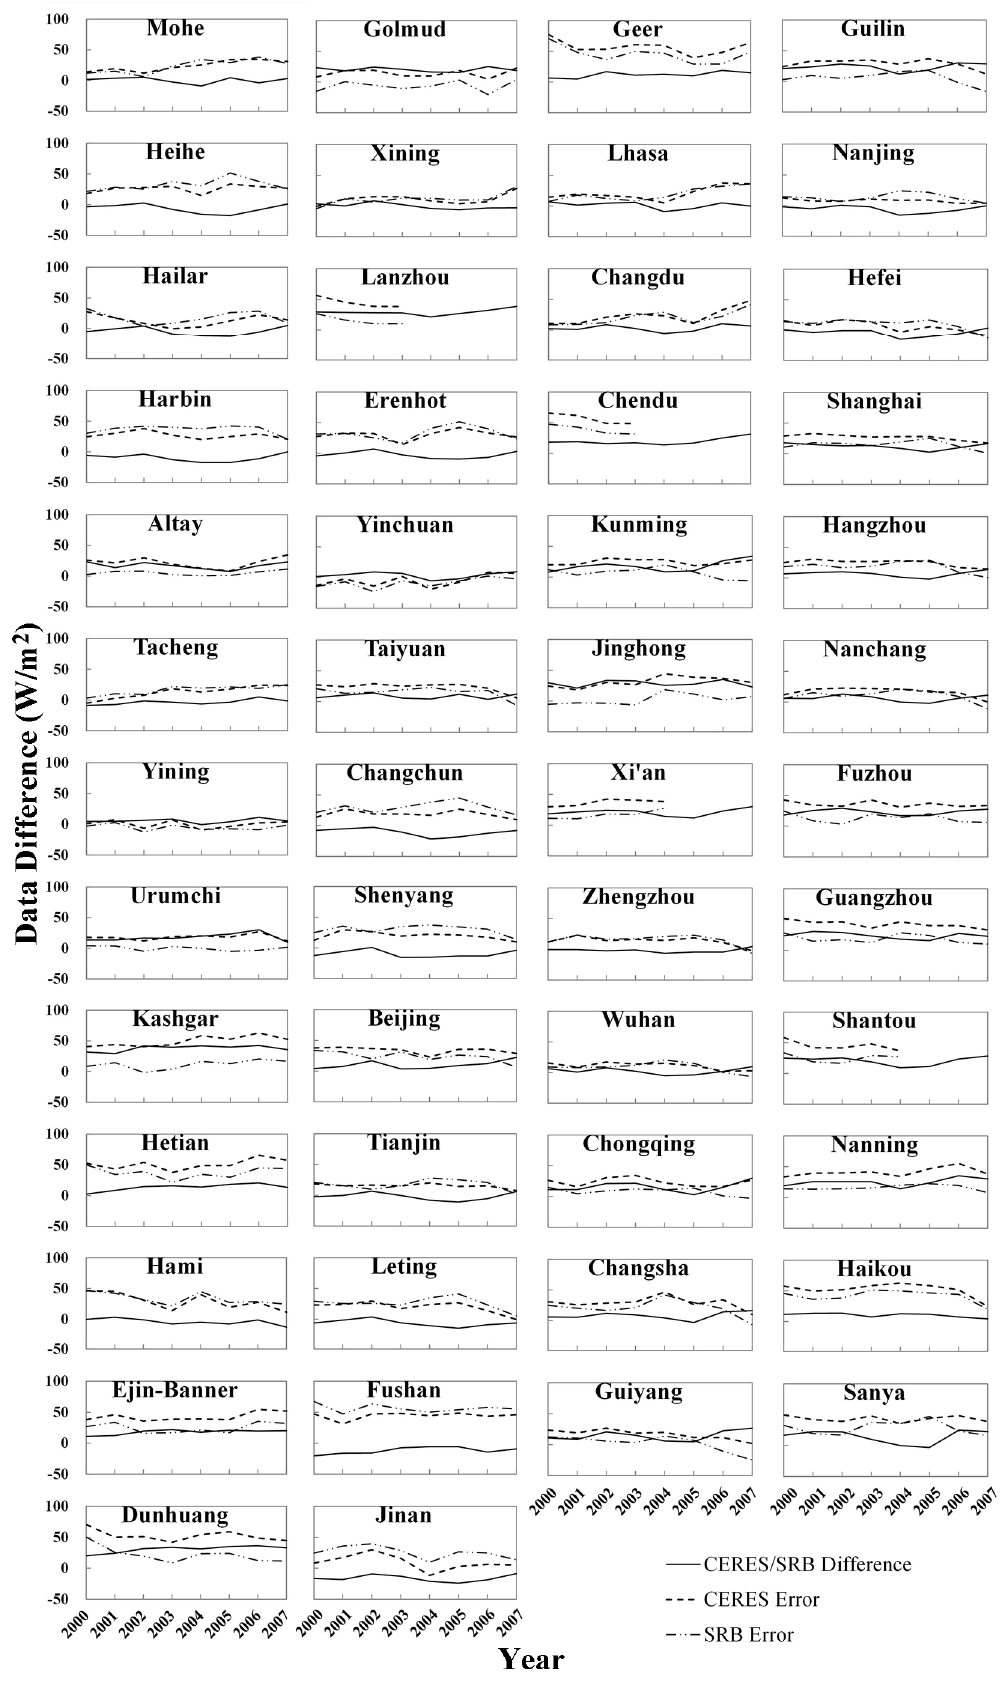
Figure 8. Annual mean errors in surface net radiation generated from the CERES and the SRB products from 2000 to